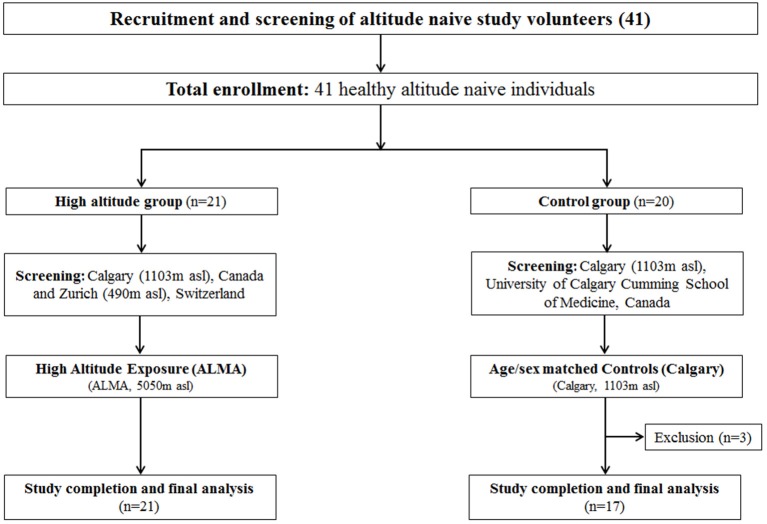
Study flowchart for Altitude and Control group study participants. Figure illustrates participant flow through the experimental protocols (CONSORT diagram) showing the flow of study participants for high altitude protocol (ALMA) and controls (Calgary). n, number; asl, above sea level; m, meter; kg, kilogram; ALMA, the Atacama Large Millimeter Array.